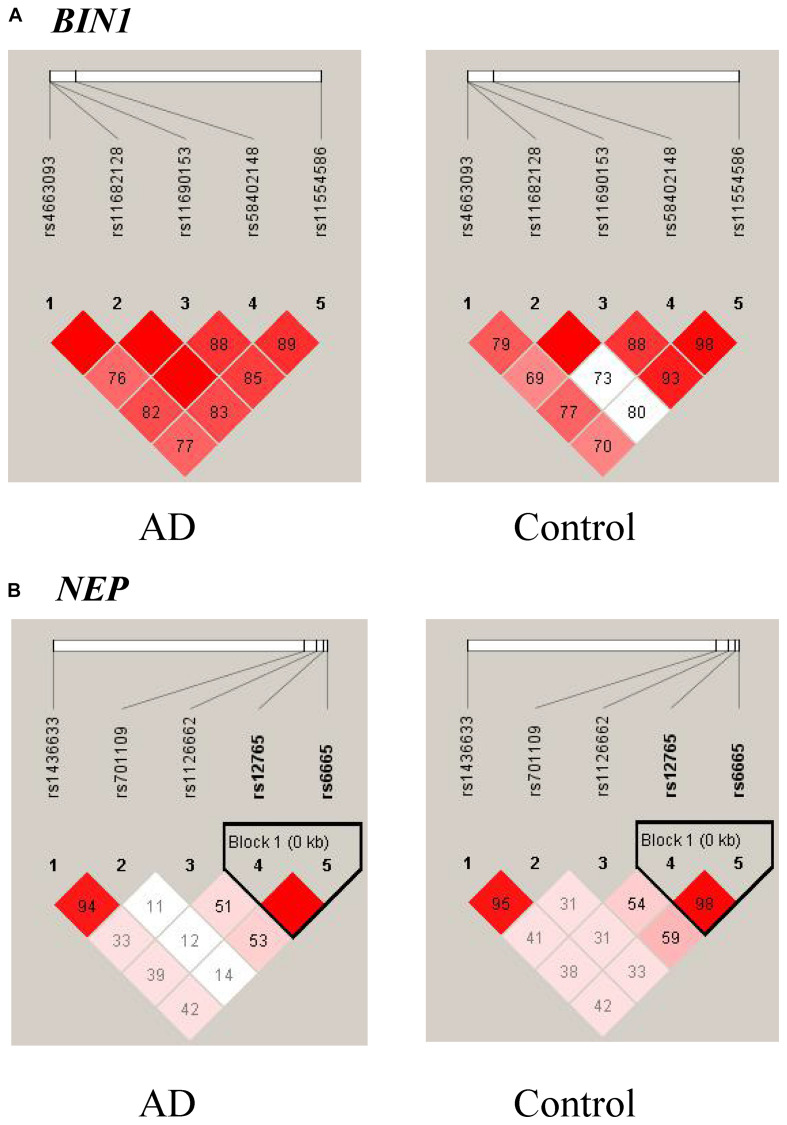
Linkage disequilibrium (LD) patterns of BIN1
(A) and NEP
(B). The value in each square is equal to r2×100.